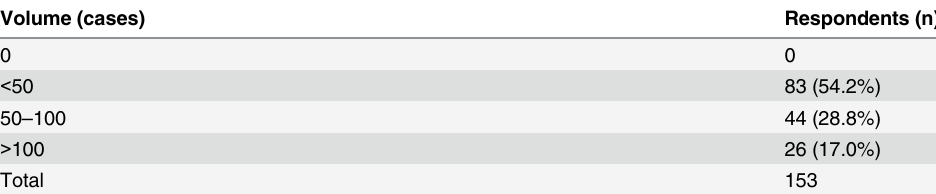
Table 1. Distribution of respondents by annual eye repair